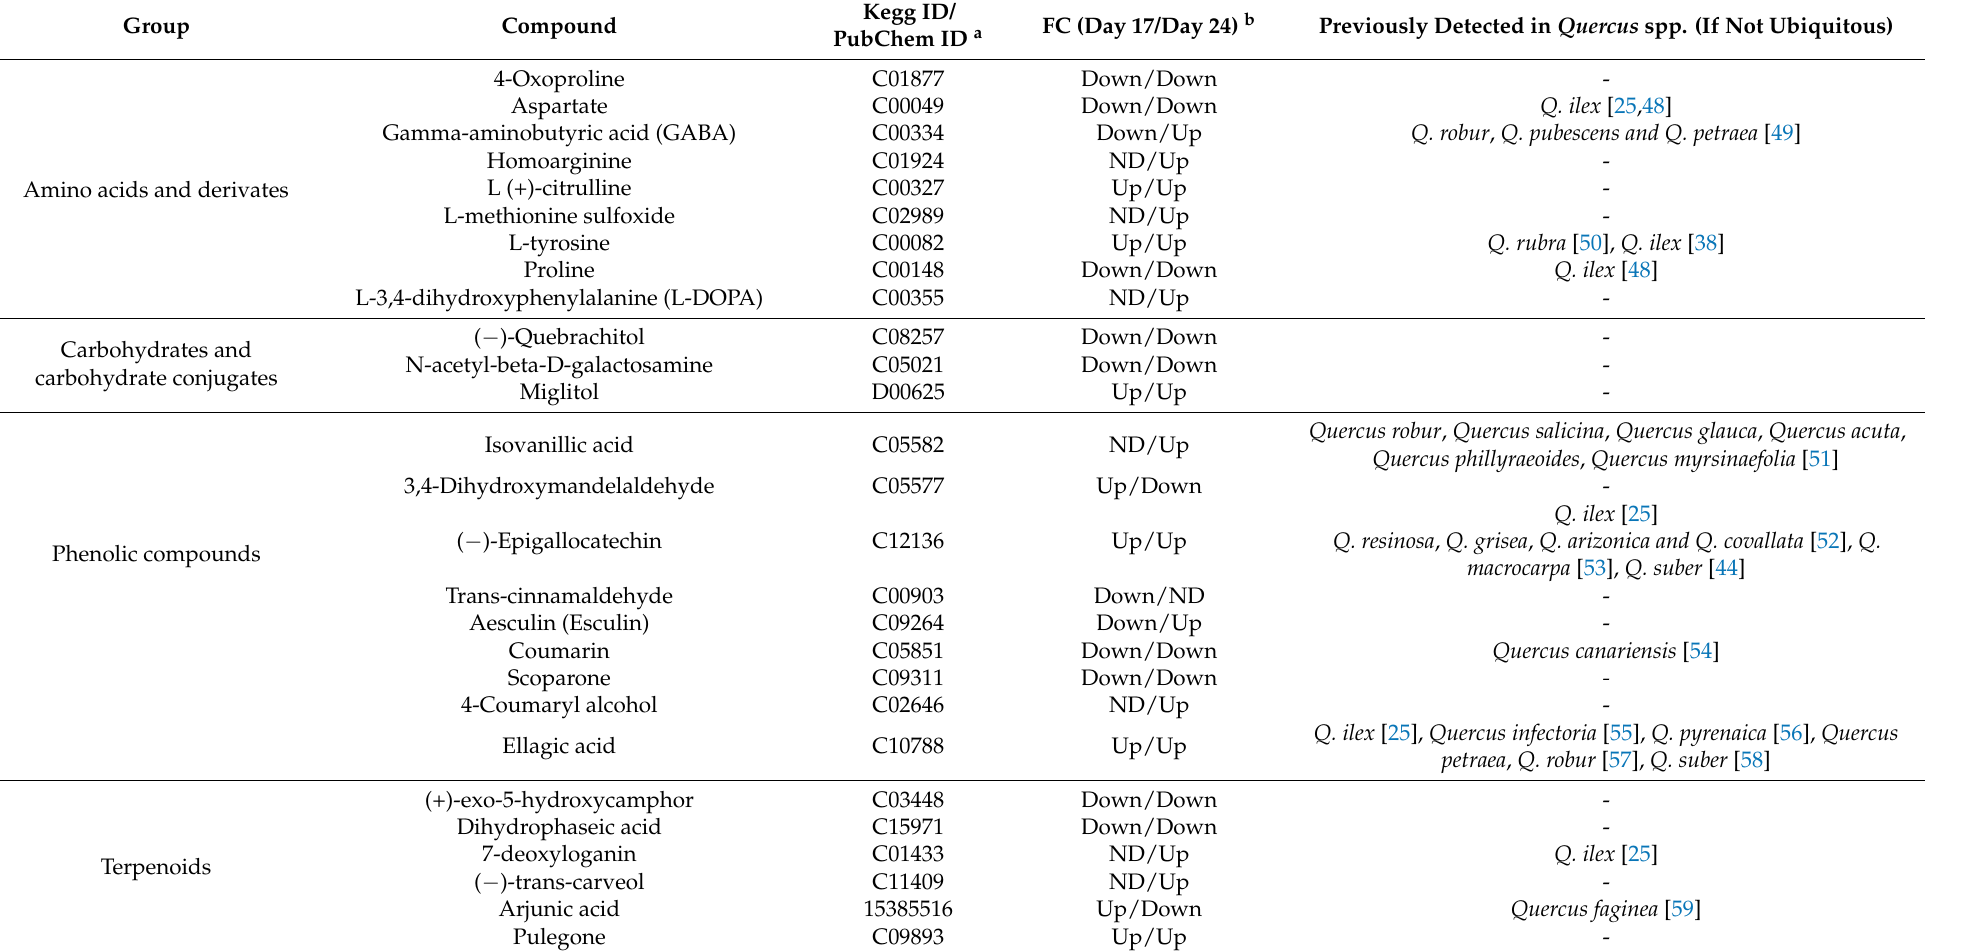
Table 3. List of variable annotated metabolites identified in Q. ilex seedlings subjected to drought conditions. Group